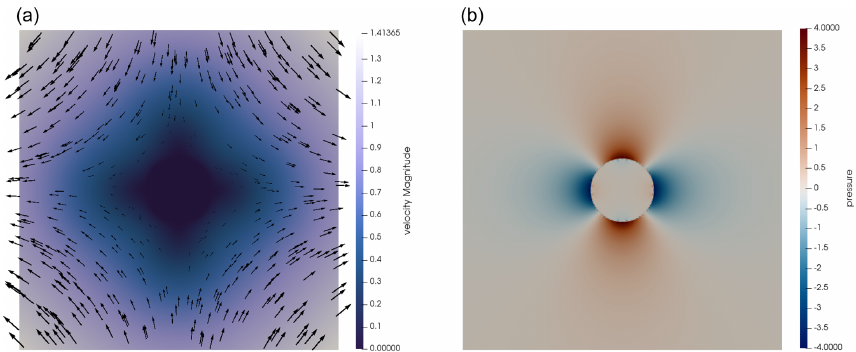
Figure 7. SolVi benchmark with inclusion of radius 0.2. Velocity (a) and pressure (b) fields obtained on a 256 × 256 mesh using Q 2 × Q 1 elements.